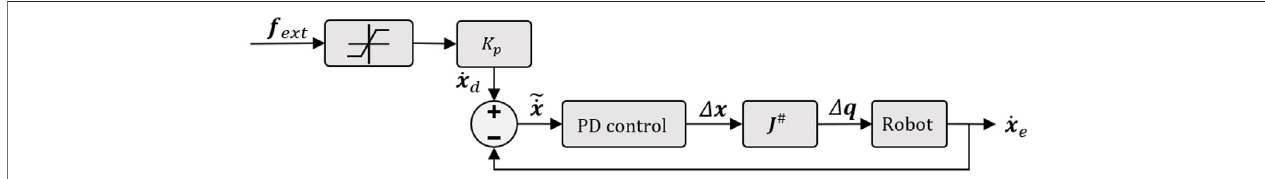
FIGURE 4 | Illustration of the implemented control scheme in case of comanipulation mode.